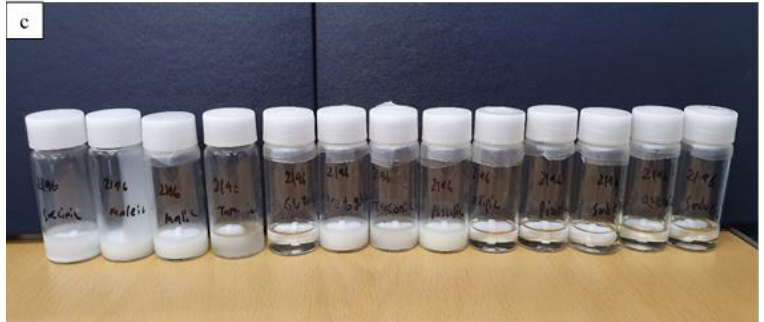
Figure 7. DPZ-IL patch solution: DPZ-succinic acid, DPZ-maleic acid, DPZ-malic acid, DPZ-tartaric